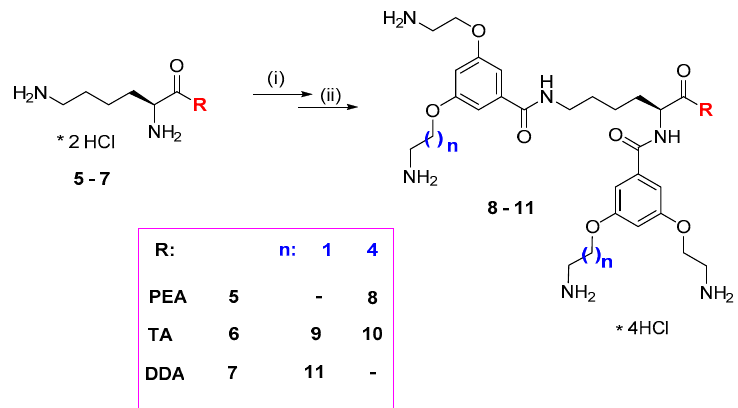
Scheme 1. Schematic representation for the synthetic pathway of branching units 4 and 5 (described in detail in [21]). Boc: tert